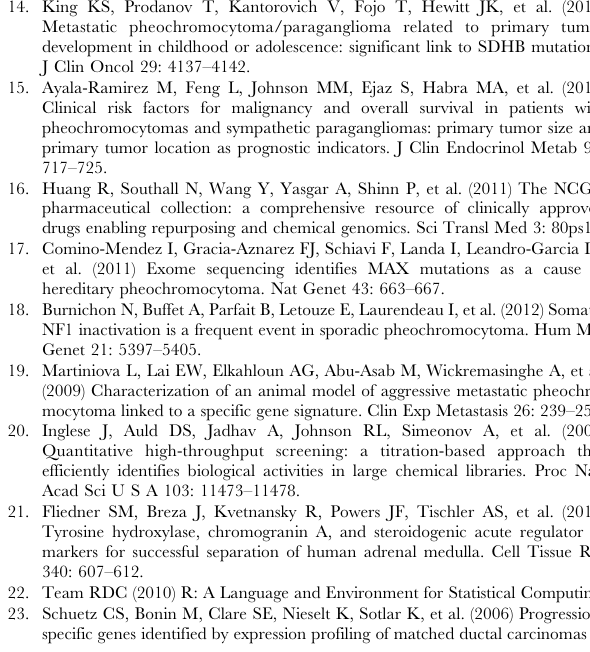
Figure S1 Enrichment analysis. Enrichment analysis (by thera- peutic category) of active compounds from the primary screening of the NPC drug library. Gray bars represent the total number of drugs in the specific therapeutic category, white bars represents the number of active compounds and black bars represents the results of the enrichment analysis as described in the Material and Methods section. The green dash line marks an enrichment ratio . 20% in the active drugs. Figure S2 Subnetwork and hubnodes. A) Subnetwork with all interactions associated with drugs that include topoisomerase (DNA replication) and histone deacetylase (telomerase mainte- nance). B) Top 20 hubnodes network derived from the global network, colored by up- and down-regulated genes common to human PHEO SDHB and murine MTT cells. Table S1 NPC library screening, top compounds. Seventy-six high-confidence active compounds identified in the quantitative